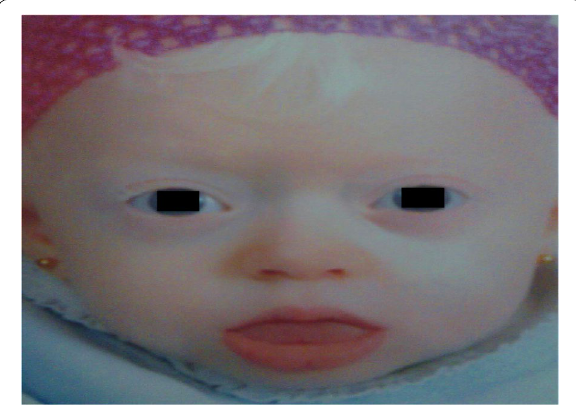
Fig. 5 The girl’s image (proband IV-2) showing generalized albinism giving the “snow white”